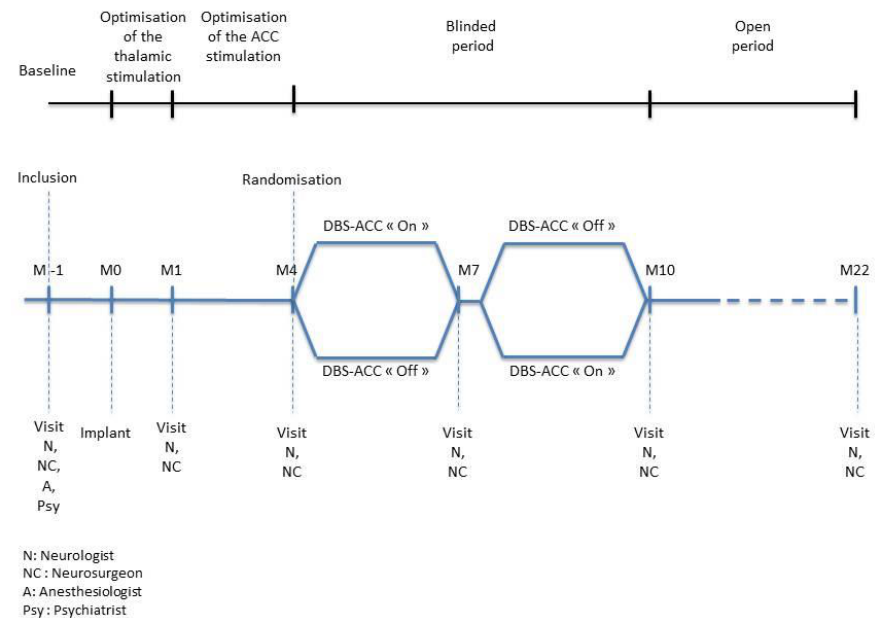
Figure 1. Study design. The study design consists of a 1-month pre-treatment evaluation phase, a phase of thalamic stimulation alone (1 month), and then thalamic and cingulate stimulation (3 months M1 to M4). A 6.5-month cross-over randomized phase will compare DBS-ACC combined with thalamic DBS to thalamic DBS alone (M4 to M7 and M7 to M10). Then a 12-month open phase will evaluate the long-term effect of combined DBS-ACC and thalamic DBS stimulation (M10 to